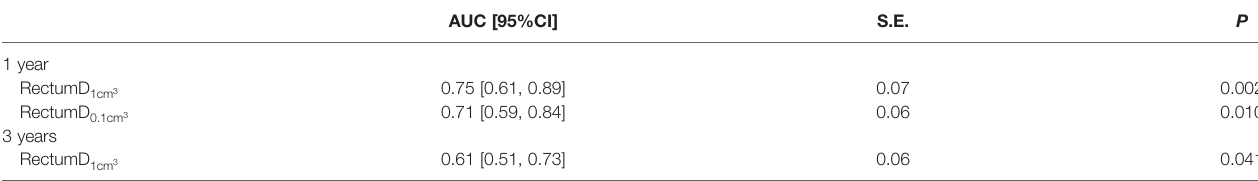
TABLE 4 | AUC of incidence of rectum morbidity grade 1 – 4.